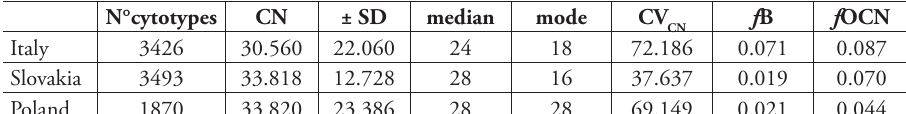
table 3. Chromosome number parameters calculated for each country dataset.